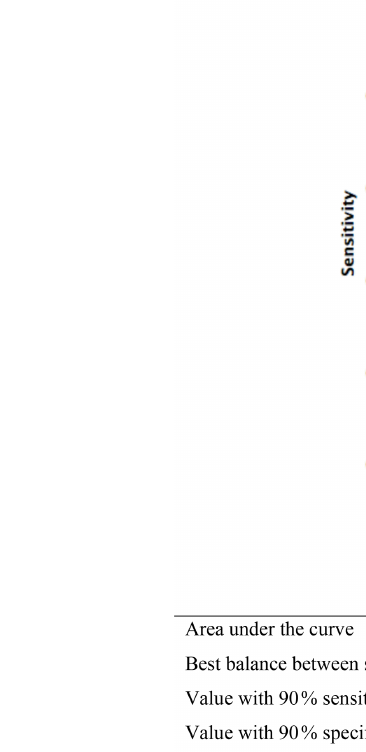
Figure 1. Receiver operating characteristic curve of serum biomarkers (D-dimer, CRP and ESR) for preoperative diagnosis of prosthetic joint infection featured in the 2018 International Consensus Meeting criteria of prosthetic joint